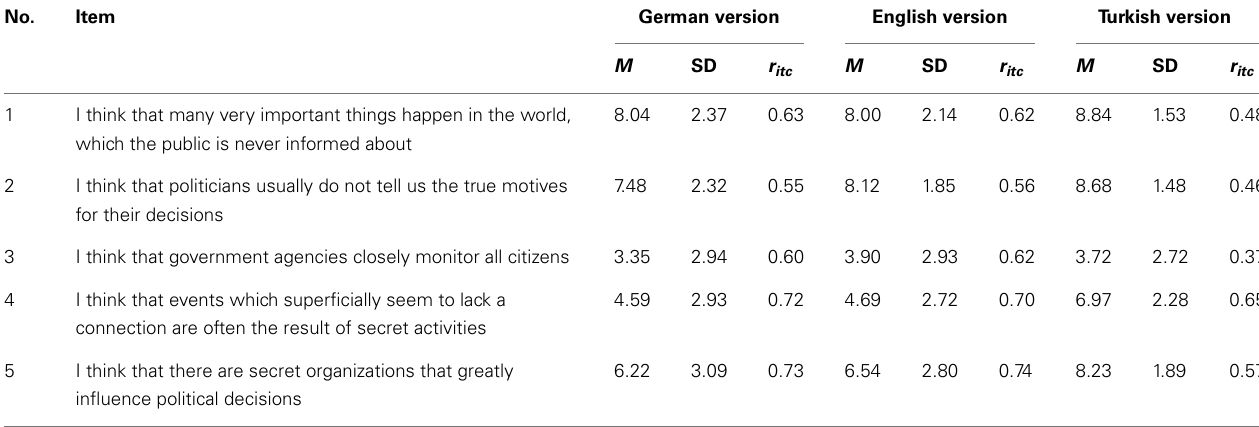
Table 1 | Conspiracy Mentality Questionnaire item statistics for each of the three language versions.